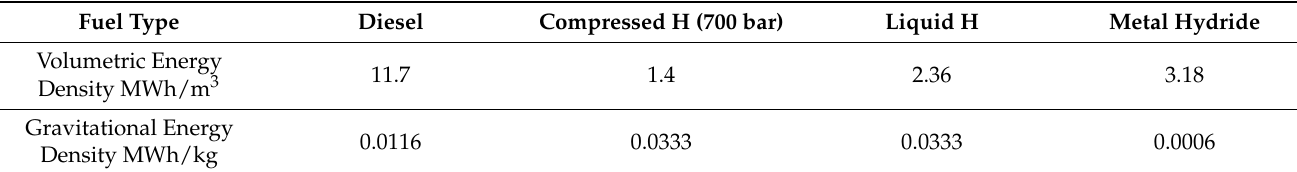
Table 2. Energy density of diesel compared to different hydrogen (H) fuel states (data from